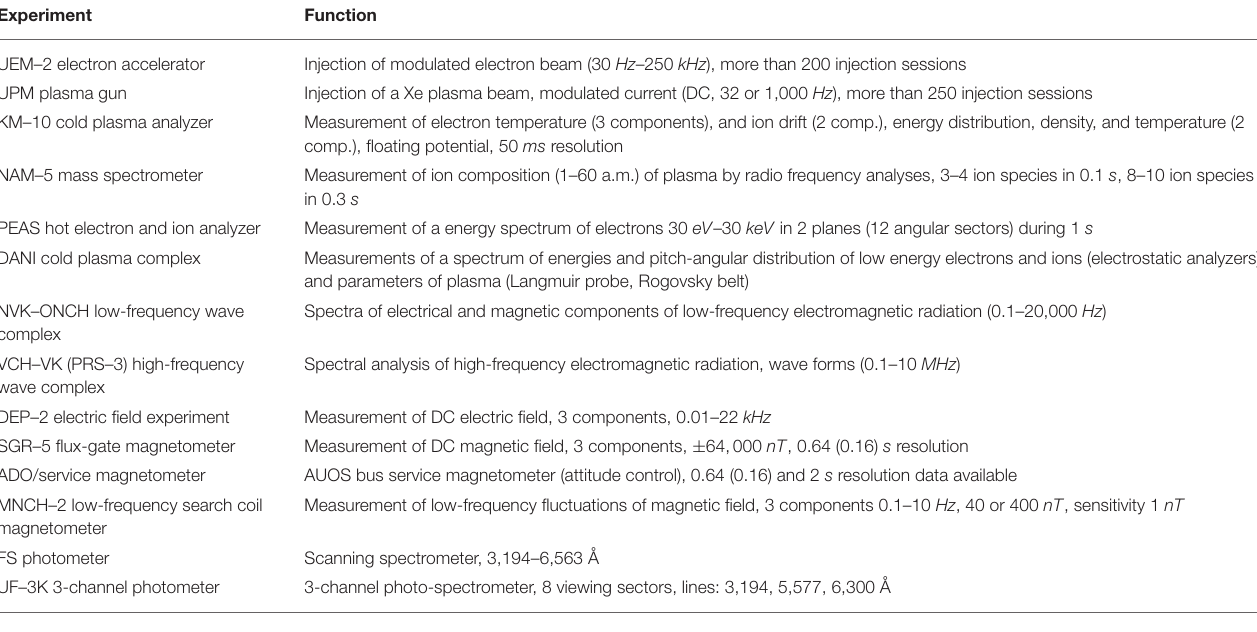
TABLE 1 | IK–25 scientific payload (Dokukin, 1992).